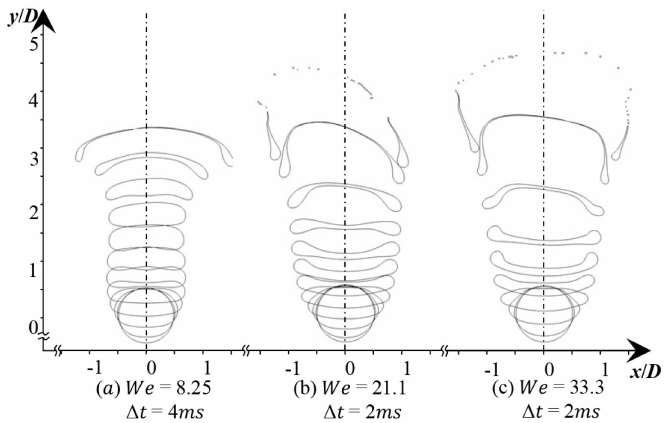
Figure 9. Evolution of droplet shape under di ff erent We numbers ( Oh =